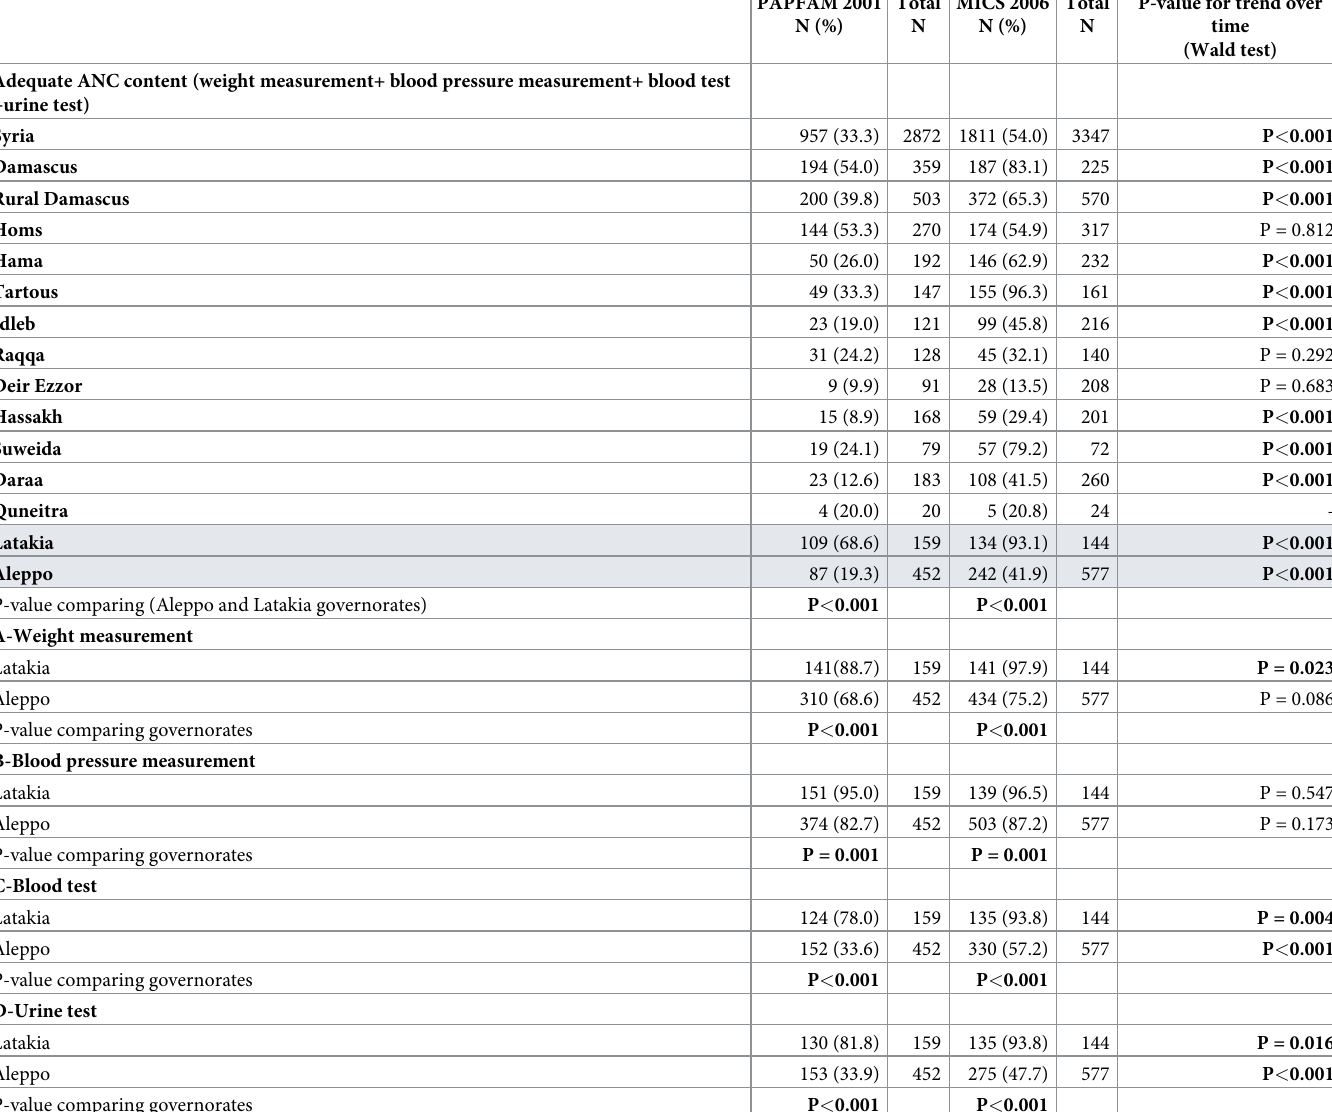
Table 1. Changes over time and percentages of women who received adequate ANC content, among women who attended ANC, PAPFAM 2001, and MICS 2006, by governorate (phase